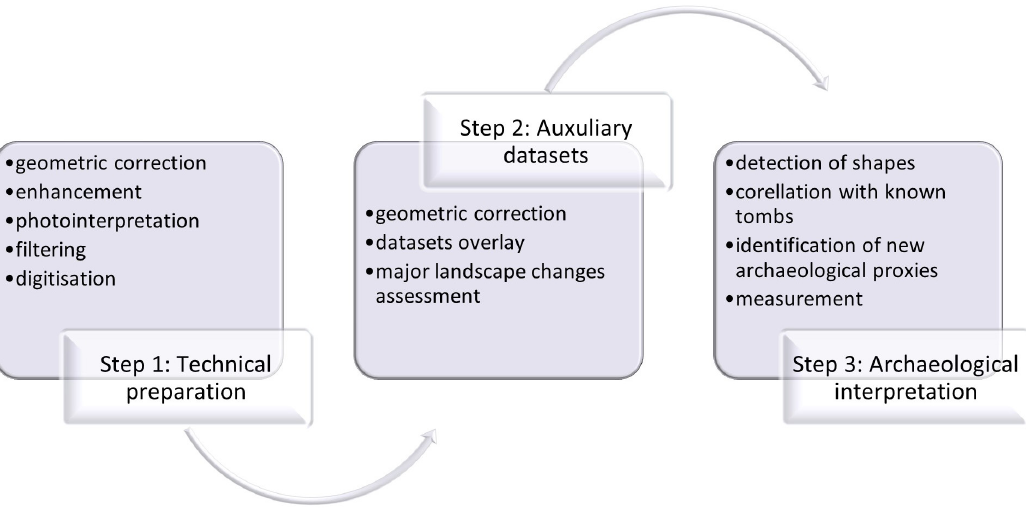
Figure 2: Methodological workflow of the present